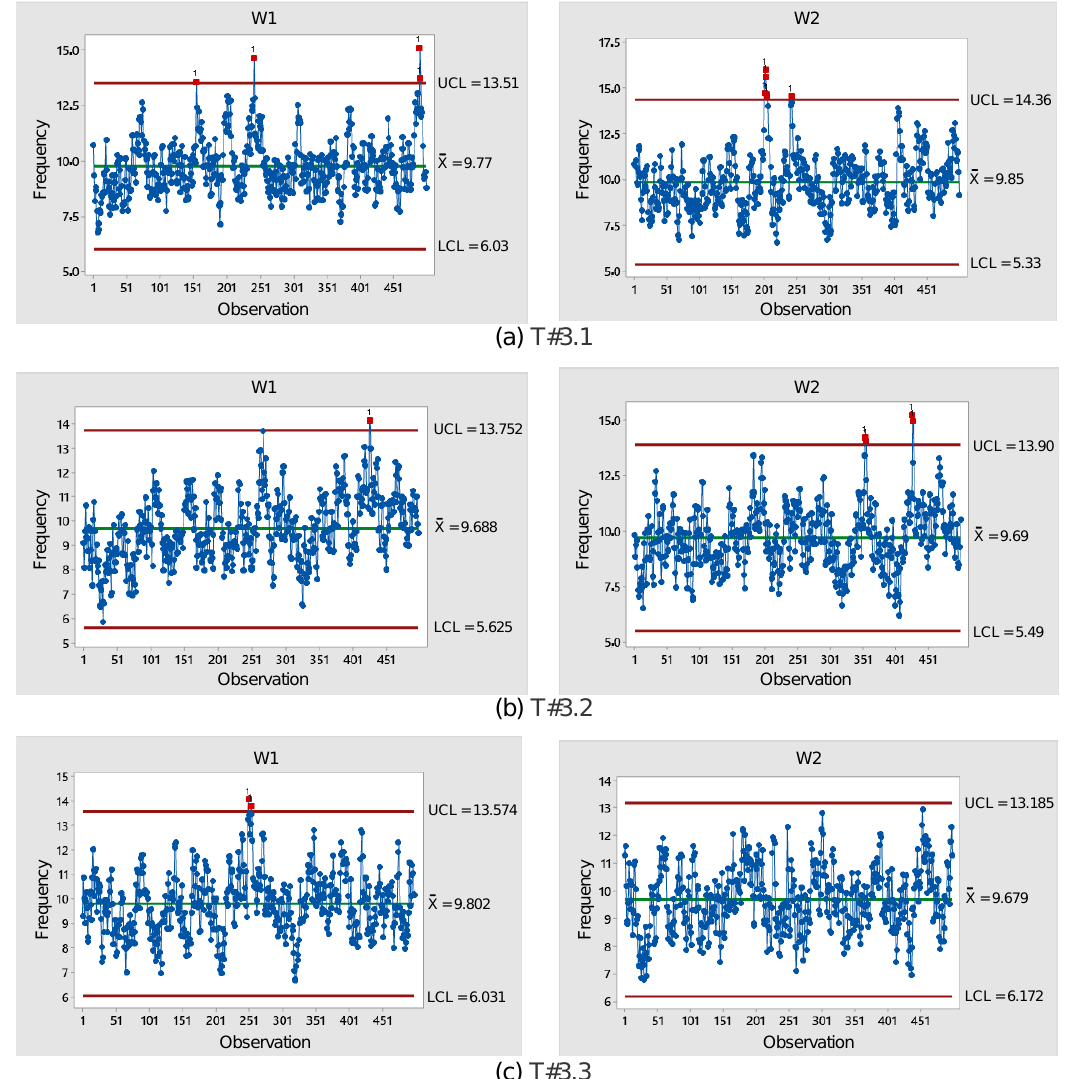
Figure 27. Control charts representing data obtained during the trial sessions carried out on firm soil with the slip automatically adjusted by the proposed control scheme.